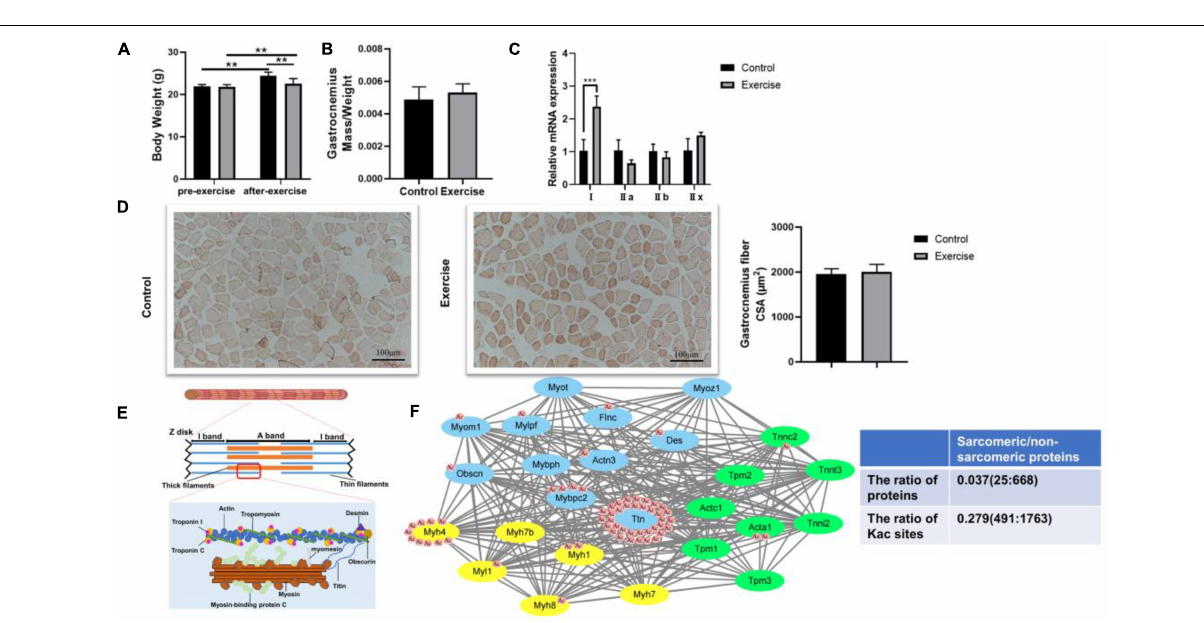
FIGURE 2 | Effect of aerobic exercise on the muscle of mice. (A) Body weight of mice was examined 48 h after treadmill exercise. ** P < 0.01. (B) Gastrocnemius muscle mass was measured and normalized to body weight. (C) The gastrocnemius muscle is mainly composed of MyHC IIb and MyHC IIx fiber. Compared with the control group, MyHC I was upregulated in the gastrocnemius of trained mice. Values are means ± SEM; n = 3 in each group; *** P < 0.001. (D) Representative Oil Red O staining of muscle sections and analysis of gastrocnemius fiber CSA in the control and exercise groups. (E) Schematic representation of muscle sarcomeres. Only the main acetylated/deacetylated proteins in the sarcomere and the basic contractile unit of skeletal muscle are shown. (F) Lysine sites of sarcomeric proteins were identified in the mouse skeletal muscle, and a protein–protein interaction network was visualized with STRING. Each green node represents proteins expressed in thin filaments, each yellow node represents proteins expressed in thick filaments, and each blue node represents sarcomere-associated proteins. Some nodes are surrounded by red circles, which represent lysine acetylation induced by exercise. The table shows the comparison of sarcomeric proteins and non-sarcomeric